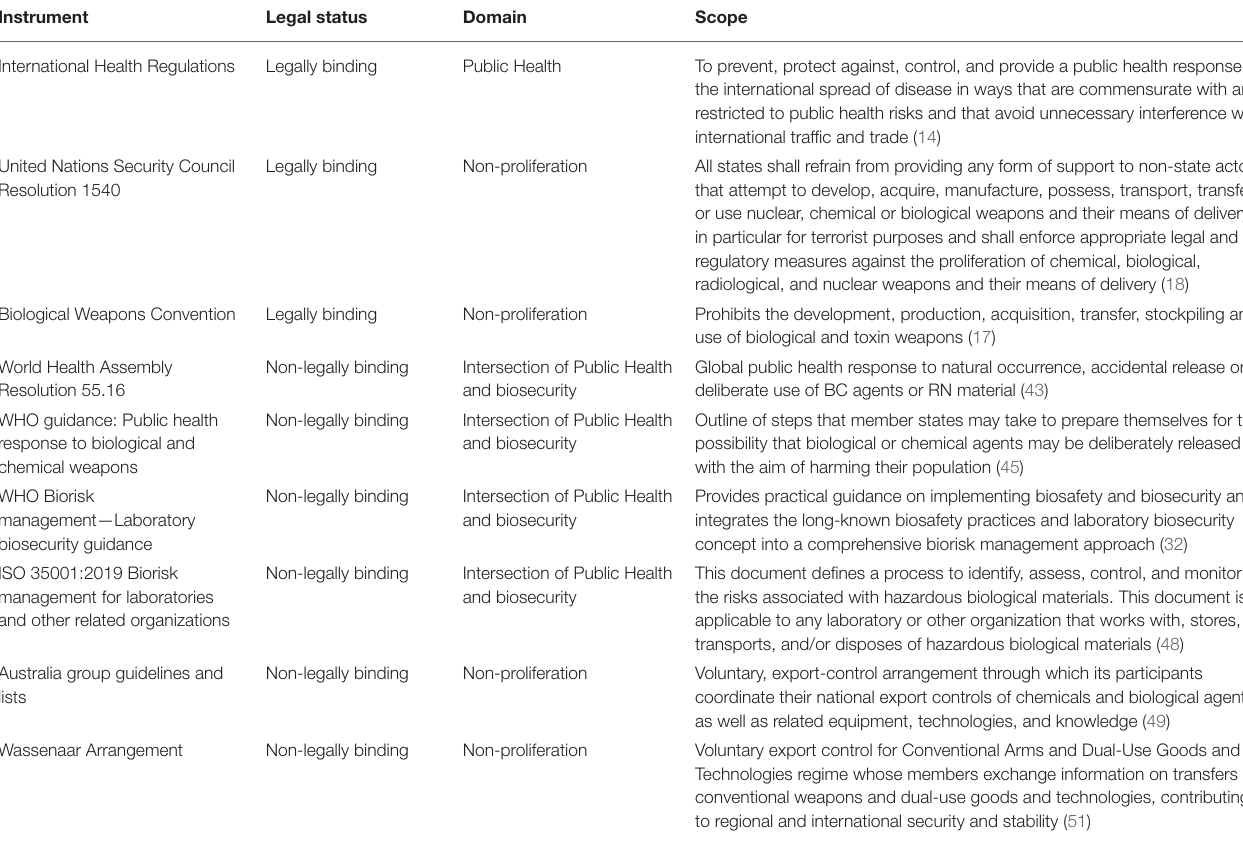
TABLE 1 | Overview of international instruments in the field of